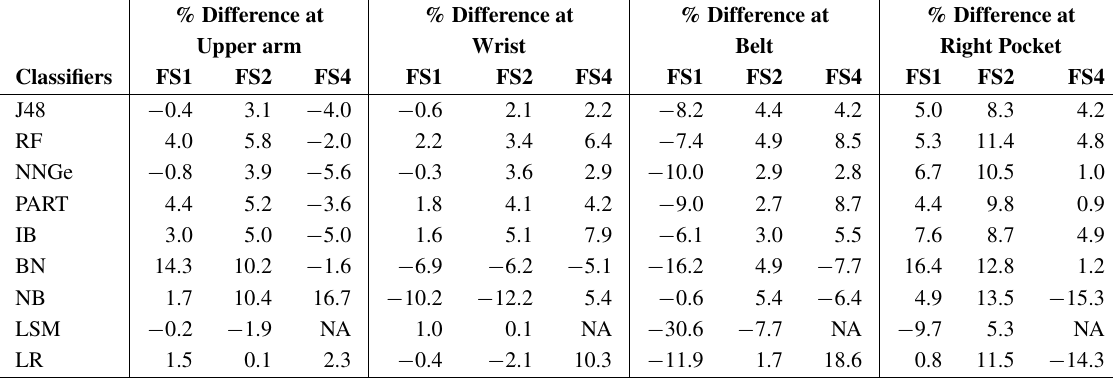
Table A.1. Performance difference (gyroscope (G)—accelerometer (A)) for the walking downstairs activity in Scenario A.